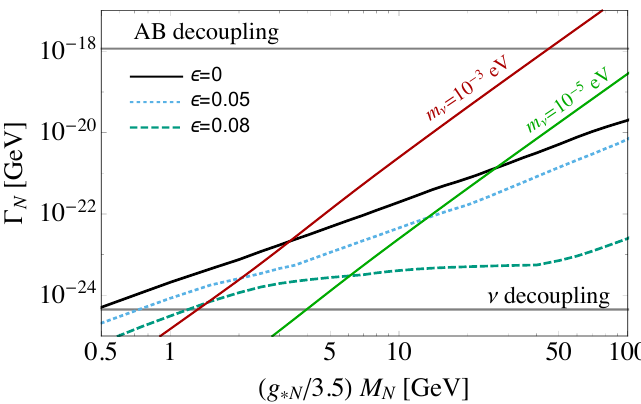
Figure 2 . The constraints on m (cid:0) (cid:0) parameter space. The reheat temperature after N decay N N must lie above the neutrino decoupling temperature, taken to be 1 MeV, and below the SM-Twin decoupling temperature, taken to be 3 GeV. We presents curves of (cid:1) N e(cid:11) = 0 : 6 and we have assumed the ratio of EW breaking scales f=v = 3. The solid, dotted and dashed curves denote (cid:15) = 0 ; 0 : 05 and 0 : 08 respectively, and the region with (cid:1) N e(cid:11) (cid:20) 0 : 6 lies below the corresponding curve. The red and green solid lines correspond to the width of the right handed neutrino in the model described in section 4, showing that this model produces a viable